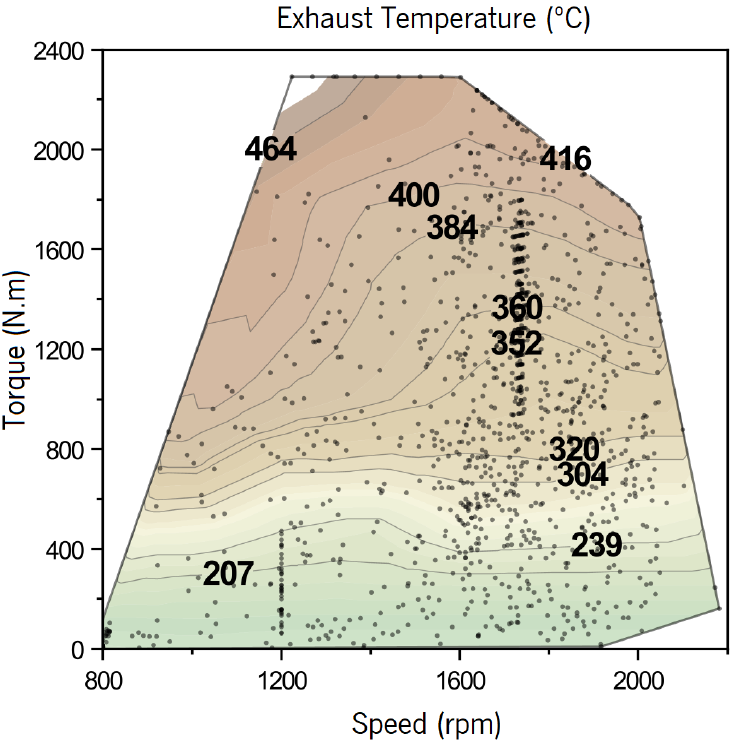
Figure 7. Exhaust gas contour map: exhaust gas temperature at the aftertreatment outlet.